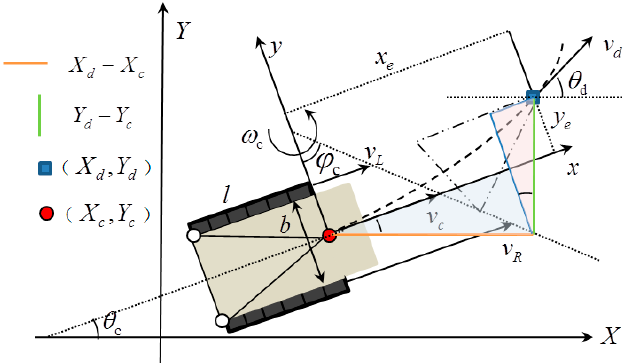
Figure 2. Illustration of the position and orientation adjustment for the roadheader. ( x , y ) and ( X , Y ) are the coordinates of the roadheader in the vehicle coordinate system xoy and geodetic coordinate system XOY , respectively. The letter b presents the distance between the two tracks; v presents the instant heading velocity; ϕ presents the turning angle of the roadheader; ω presents the turning angular speed, which is also the orientation of the